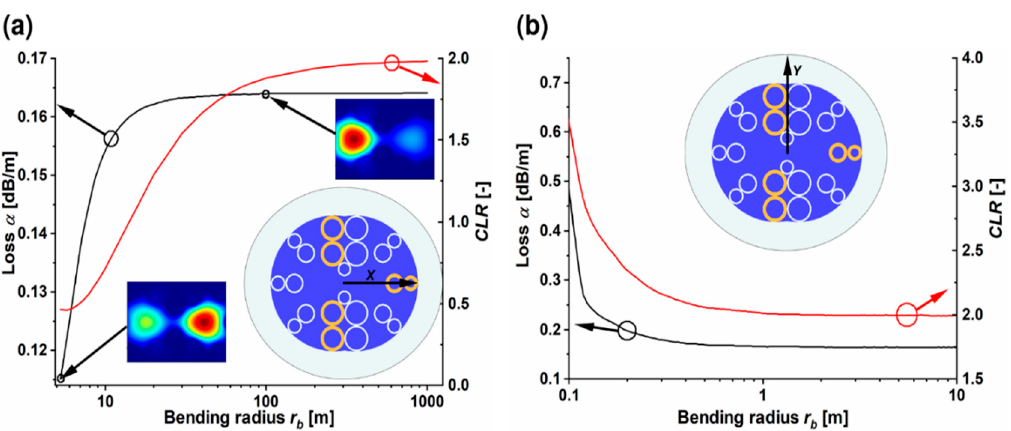
Figure 3. Bending properties of the DHC-ARF. Loss and CLR coefficient for different bending radii along ( a ) the X -axis and ( b ) Y -axis. The insets present the cross section of the DHC-ARF together with the black arrows indicating the orientation of the bending direction (marked as X or Y in the cross-section of the structure). Additionally, in ( a ) two mode profiles at r b = 5 m and 100 m are presented, showing the energy transfer between the cores as the bending increases. The red and black arrows, connected with the circles of the same color, indicate the Y -axis corresponding to the circled curve.